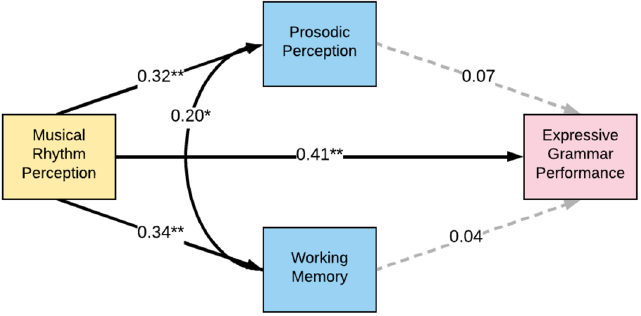
Figure 3. Path analysis model of associations between musical rhythm perception and expressive grammar. The path analysis model shows the associations between musical rhythm perception, expressive grammar task performance, prosodic perception and working memory, while controlling for age ( n = 109). Z-scored age- regressed residuals of the z-scored raw scores were used for all measures. We found that though the relationship between musical rhythm perception and expressive grammar task performance (path A) is positive and significant, it is not explained by prosodic perception (path BC) or working memory (path DE). The model uses list-wise exclusion for missing values. The β for each pair of variables is indicated on the path. Solid lines indicate a significant relationship. *signifies p < 0.05, while **signifies p <